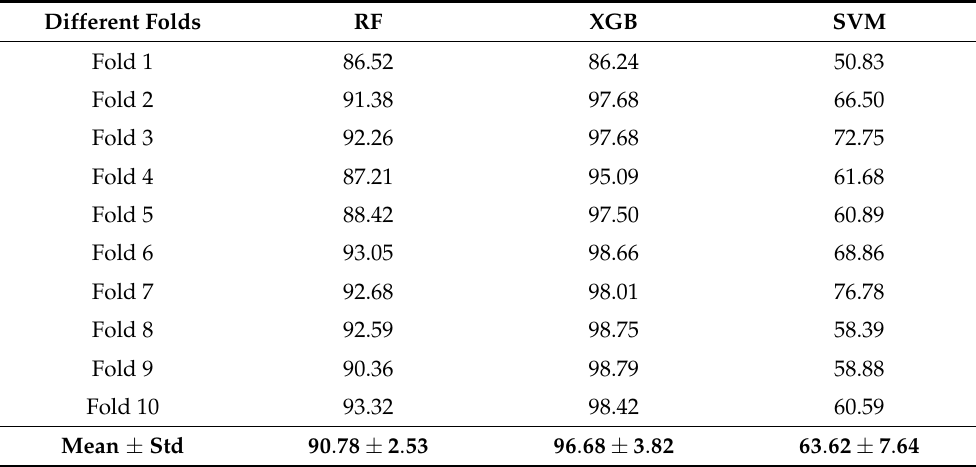
Table 5. A 10-fold cross-validation accuracy for the main three classifiers (RF, XGB, and SVM). The best Mean ± Std value is archived from XGB, which is 96.68 ±